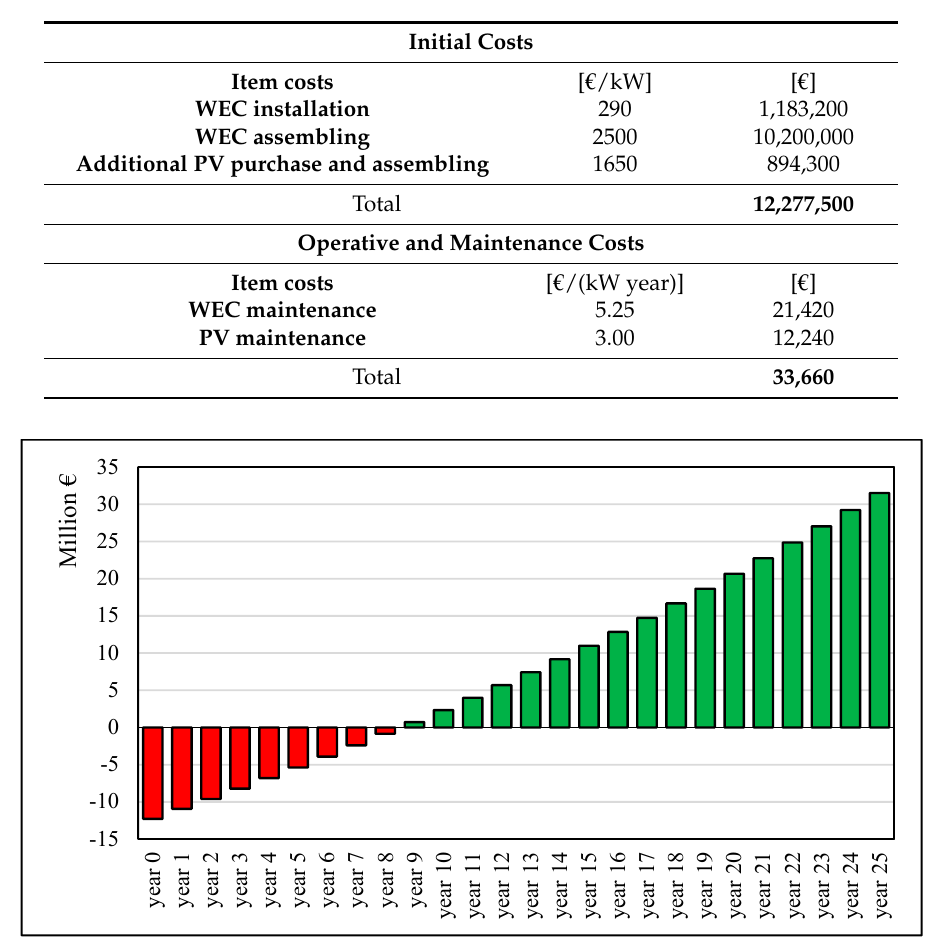
Figure 12. Discounted flow cash of wave farm investments.